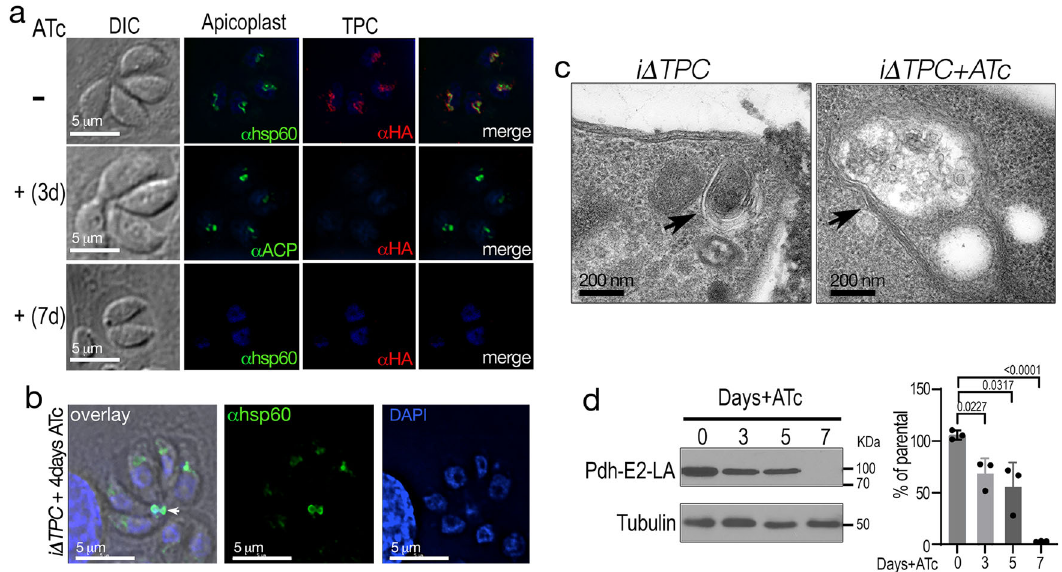
Fig. 3 Downregulation of the TgTPC impacts integrity and function of the apicoplast. a IFA with α HA showing that TPC is not expressed after 3-days of culture with ATc. The signal corresponding to the apicoplast is still present as detected with α ACP. However, after 7 days with ATc the apicoplast marker Hsp60 is no longer detectable. N = 3. b labeling of the apicoplast components at the residual body 4 days after ATc treatment. Labeling of the apicoplast was done with α hsp60 (1:1,000). Arrow shows the α hsp60 and DAPI signals at the residual body. N = 3. c Routine electron microscopy of the i Δ TPC grown in the presence of ATc, showing that the apicoplast becomes vacuolated . N = 2. d Lipoylation of PDH-E2 was detected by western blot analysis with an anti-lipoylated-PDH-E2 antibody (clone3H-2H4 1:1,500 dilution) . i Δ TPC cells treated with ATc showed decreased lipoylation of PDH-E2. N = 3. Student ’ s t - test was used: 3 versus 0 days, p = 0.0227. 5 versus 0 days, p = 0.0317. 7 versus 0 days, p < 0.0001. Data are presented as mean ± SD. p value: unpaired two tailed t test performed in all